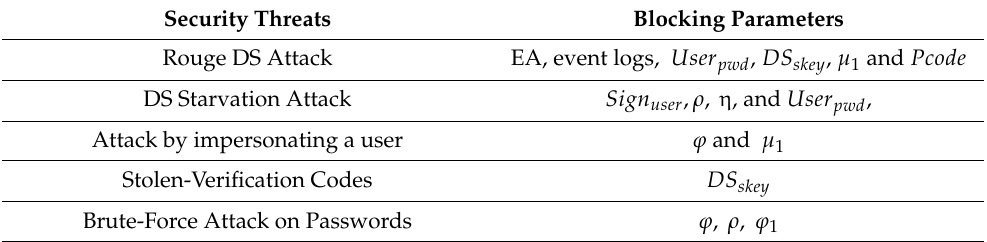
Table 3. Security analysis